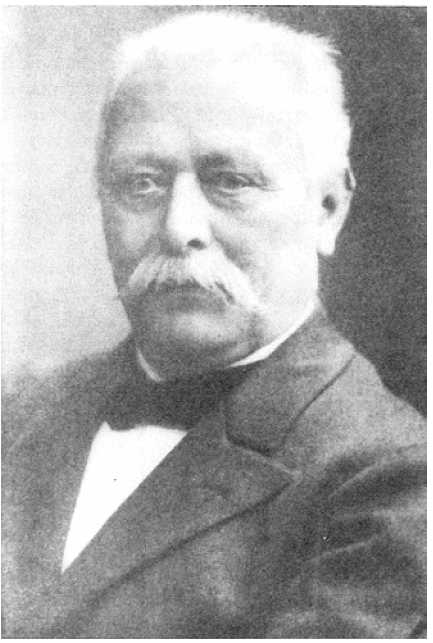
Figure 1. Adolf Thiem around the year 1900 (Franke and Klein- schroth,